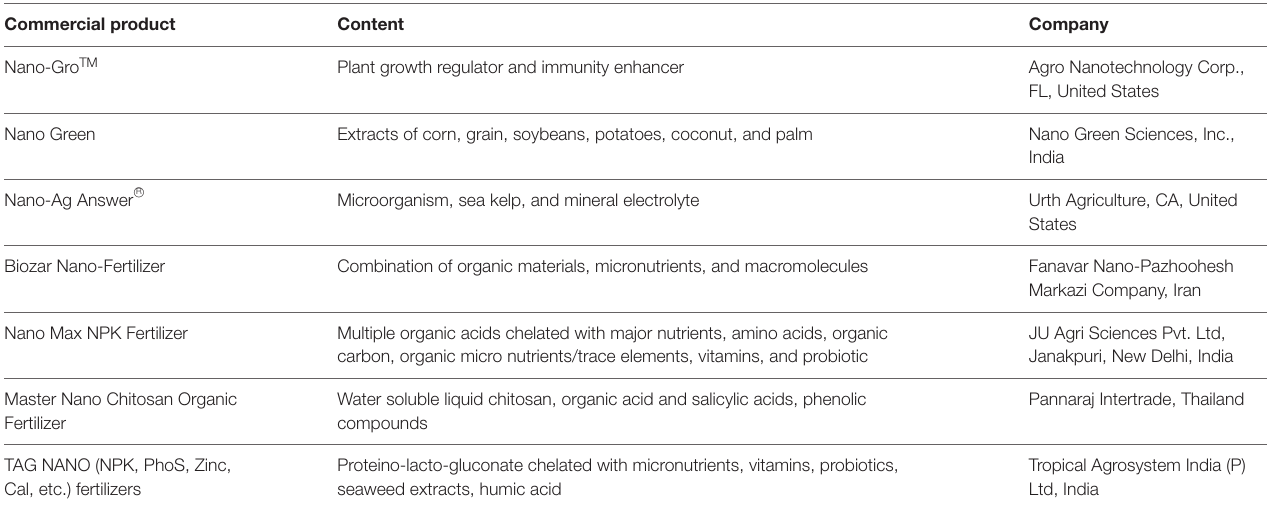
TABLE 1 | Some commercial product of